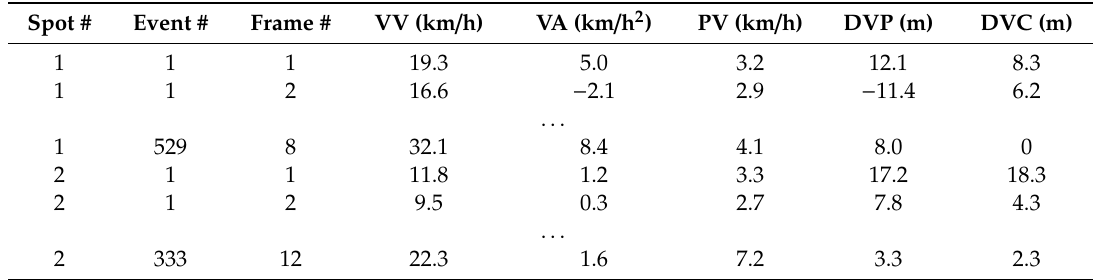
Table 2. Example of the structured dataset for